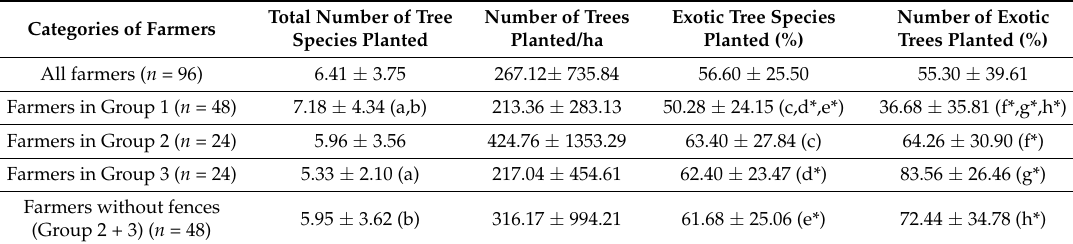
Table 2. Mean and standard deviations of the four variables used to assess tree plantation practices of the three groups of farmers. For the three groups, couples of values marked with the same letter and an asterisk are significantly different from each other, (Wilcoxon Mann Whitney test; p value < 0.05). Values with the same letter and no asterisk are significantly different with p value < 0.1 (this second cut-off value was used to detect patterns, despite the small size of the sample). Group 1 = farmers with fences; Group 2 = farmers without fences, in the same villages as Group 1; Group 3 = farmers without fences, in different villages from Group 1 and 2. Group 2 + 3 = it includes all farmers without fences, as opposed to farmers with fences in Group